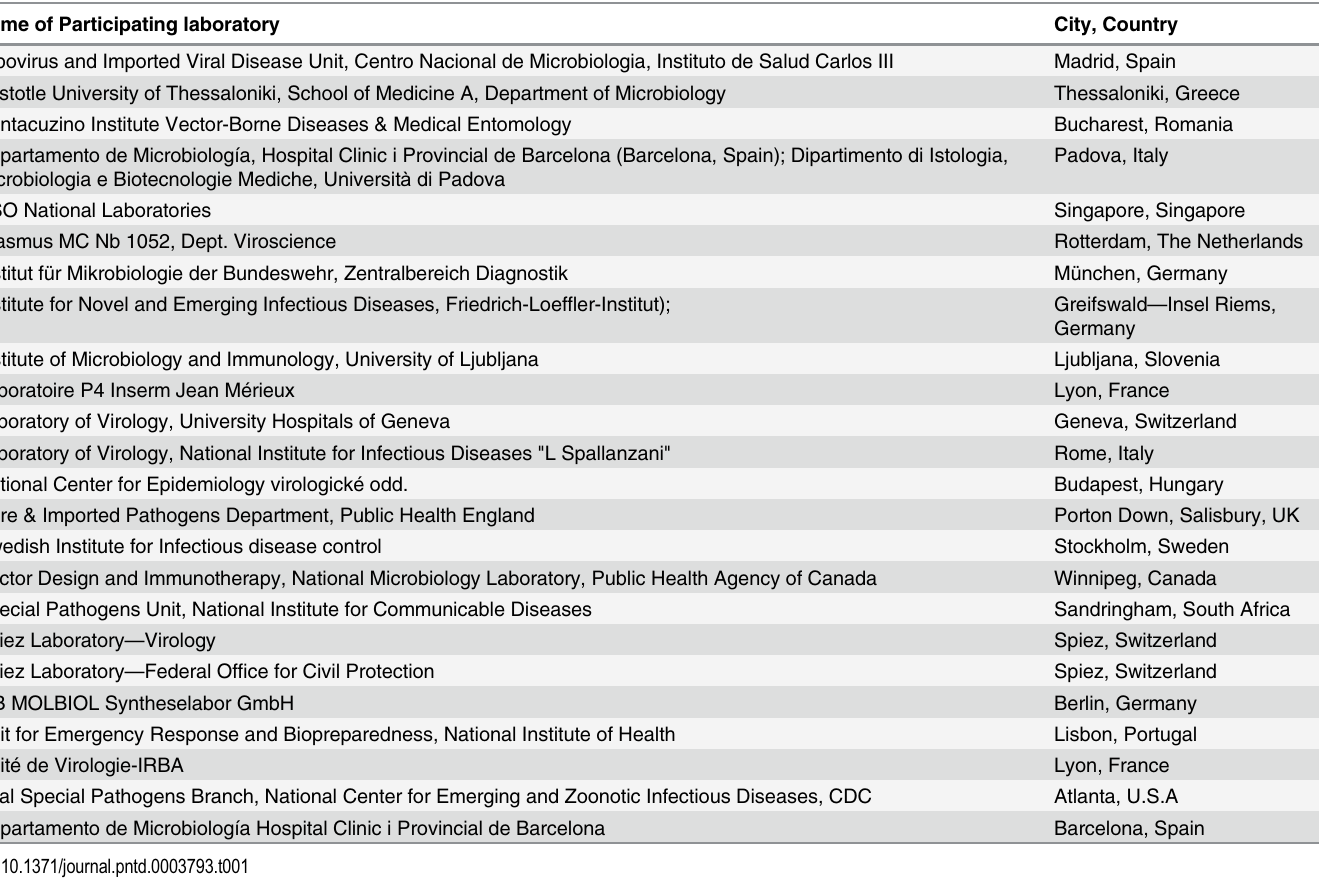
Table 1. List of participating